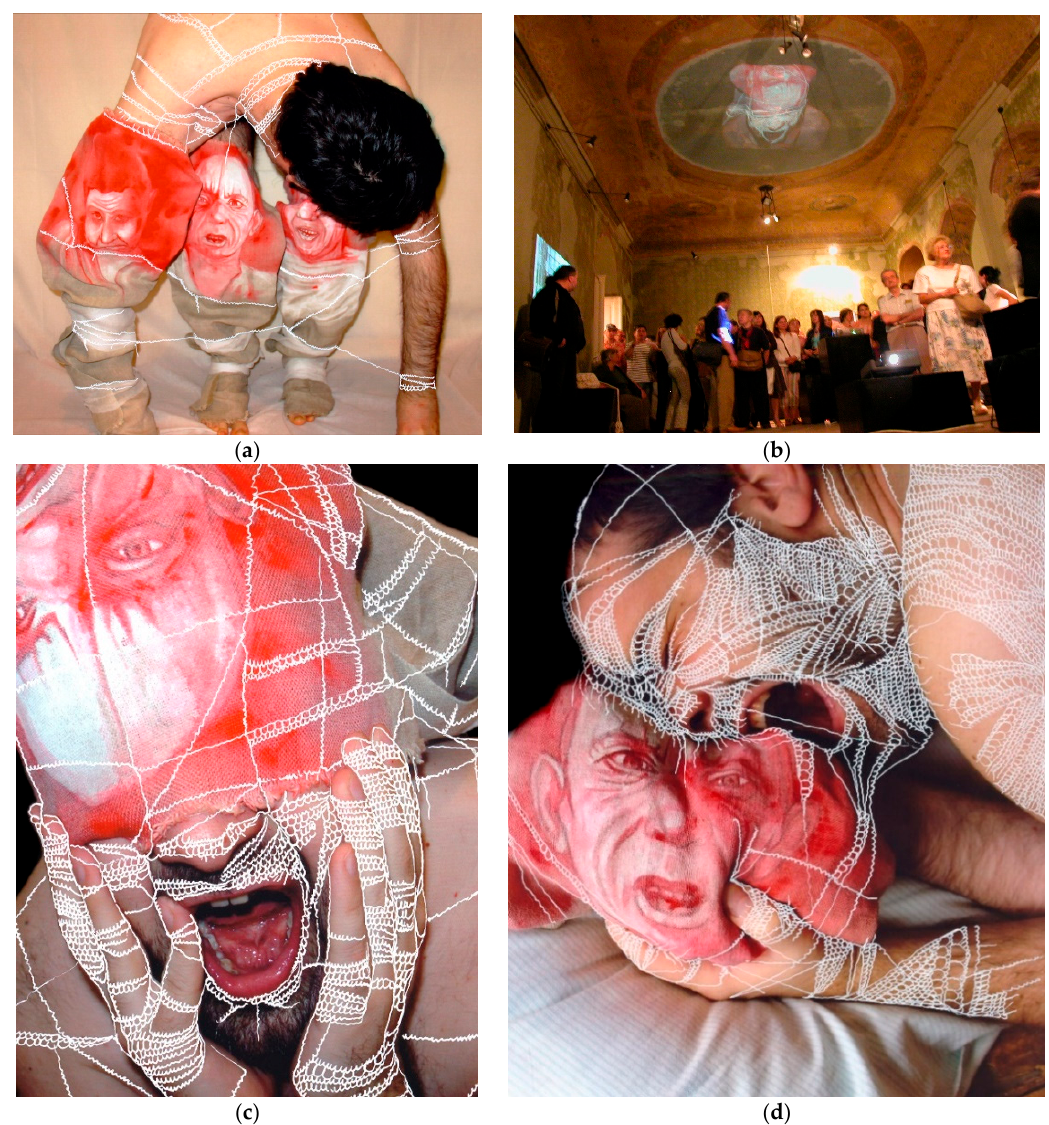
Figure 1. Peter Tzanev, Ectoplastic art therapy in different formats: ( a ) Hallucinating objects, intermedia, 2003. Club for Discussions “Close Together”, Hambara, Sofia, 12 February 2004; ( b ) Hallucinating objects, intermedia, National Art Gallery, Sofia, 9 September 2005; ( c ) Hallucinating objects, intermedia, Project “Nigredo”, Central Prison of Sofia, 2005; ( d ) Hallucinating objects, intermedia, donumenta 2005, Regensburg; photos: P. Tzanev.